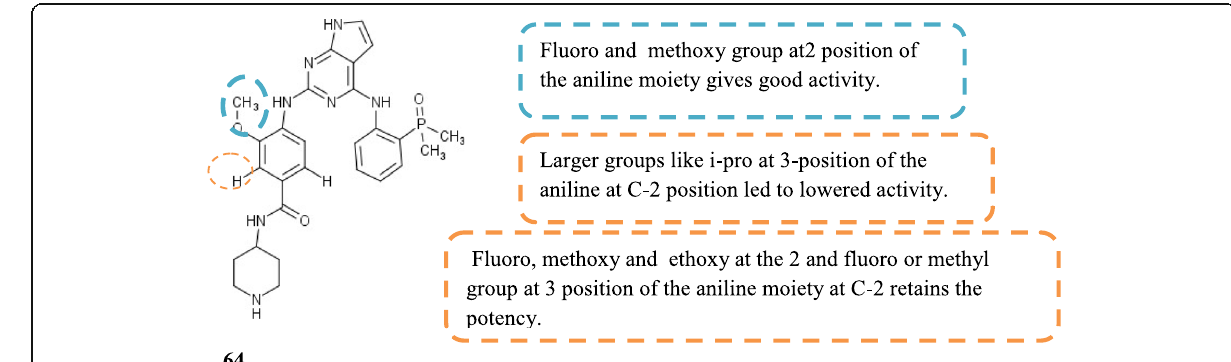
Fig. 20 SAR studies and chemical structures of 7H-pyrrolo [2, 3-d] pyrimidine derivative as FAK enzyme